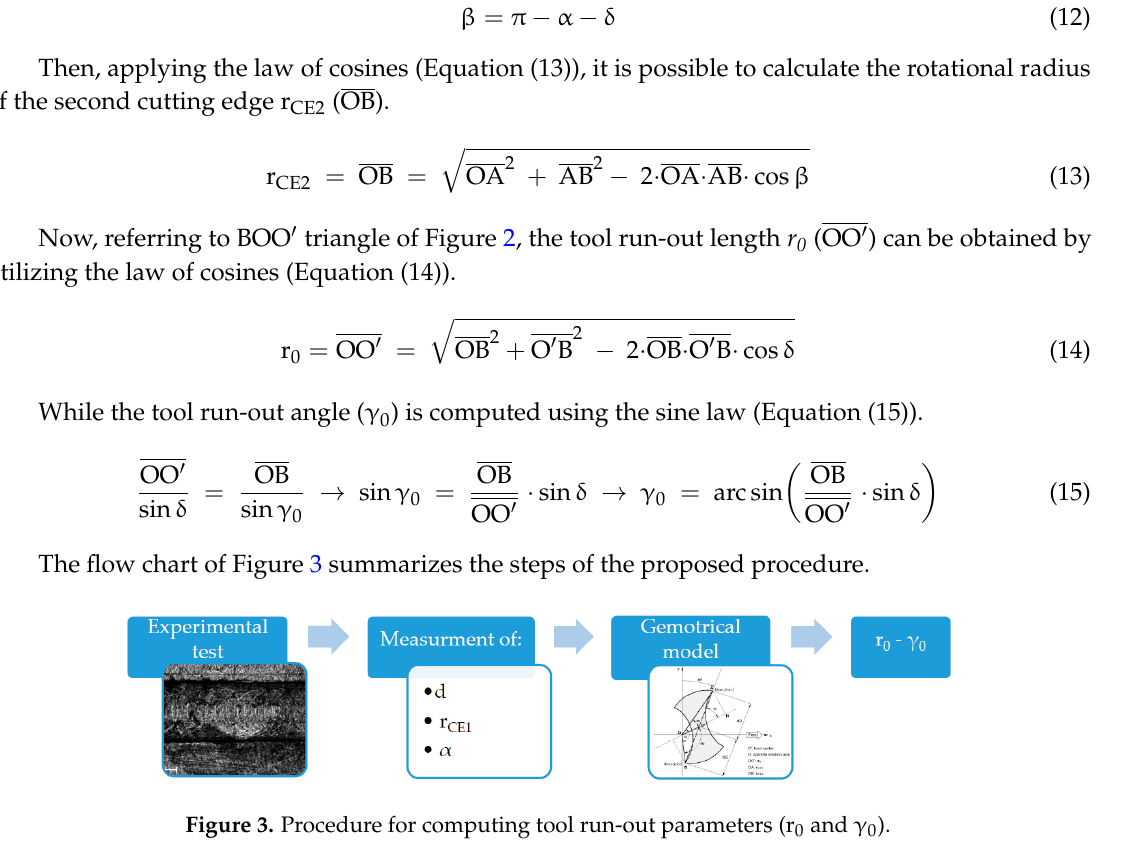
Figure 3. Procedure for computing tool run-out parameters (r 0 and γ 0 ).